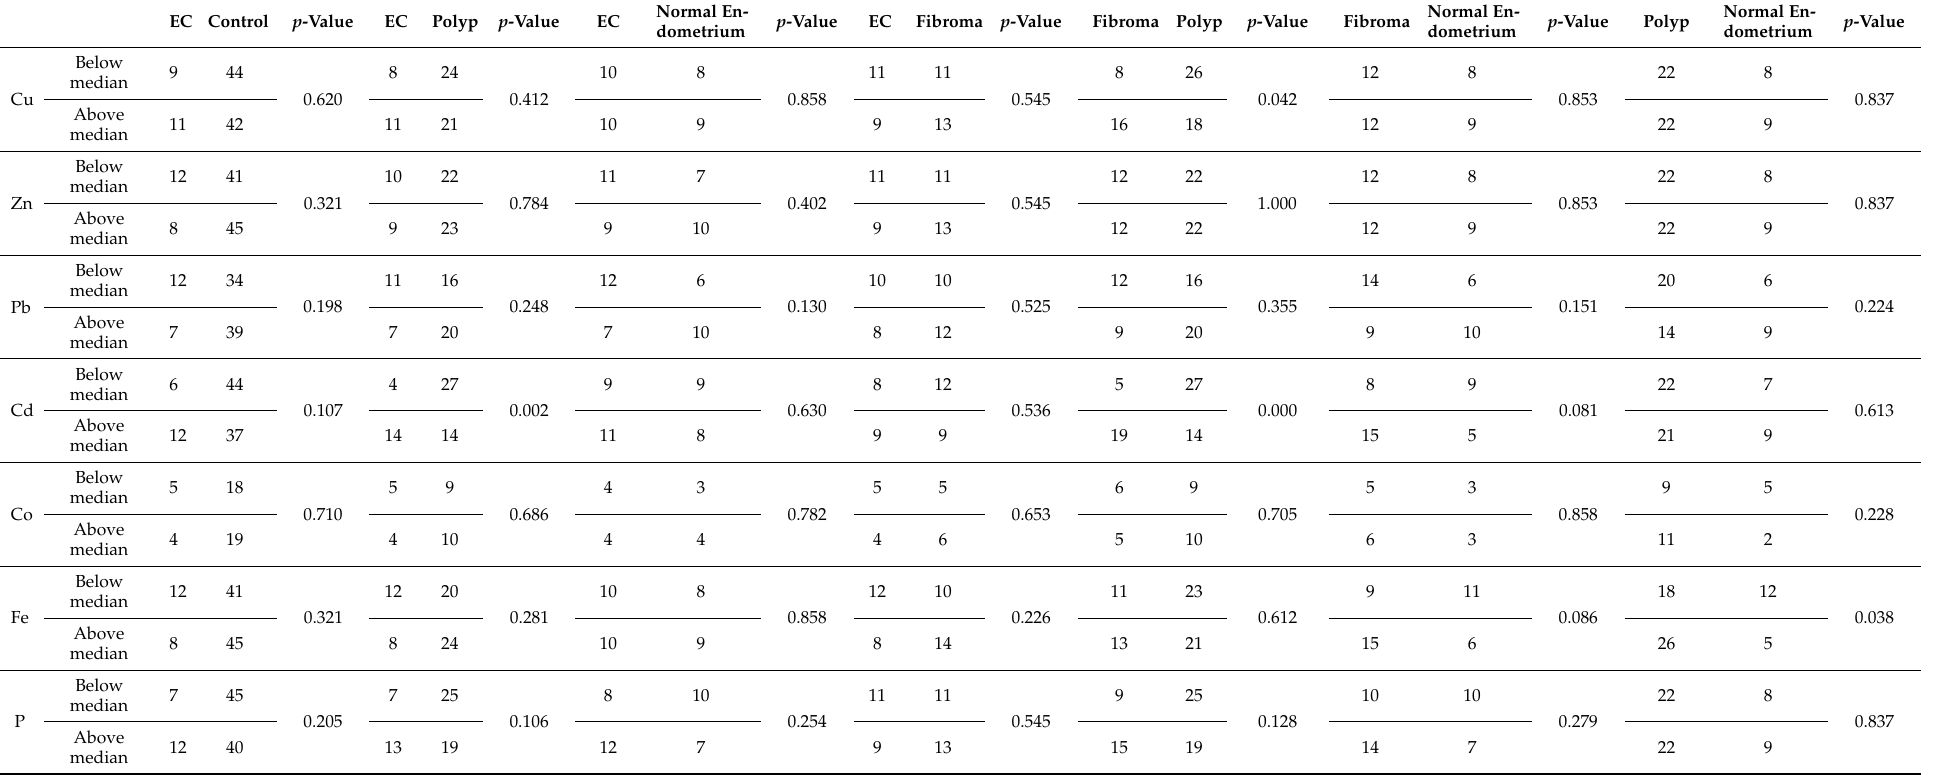
Table 2. Associations between specific trace elements levels in selected